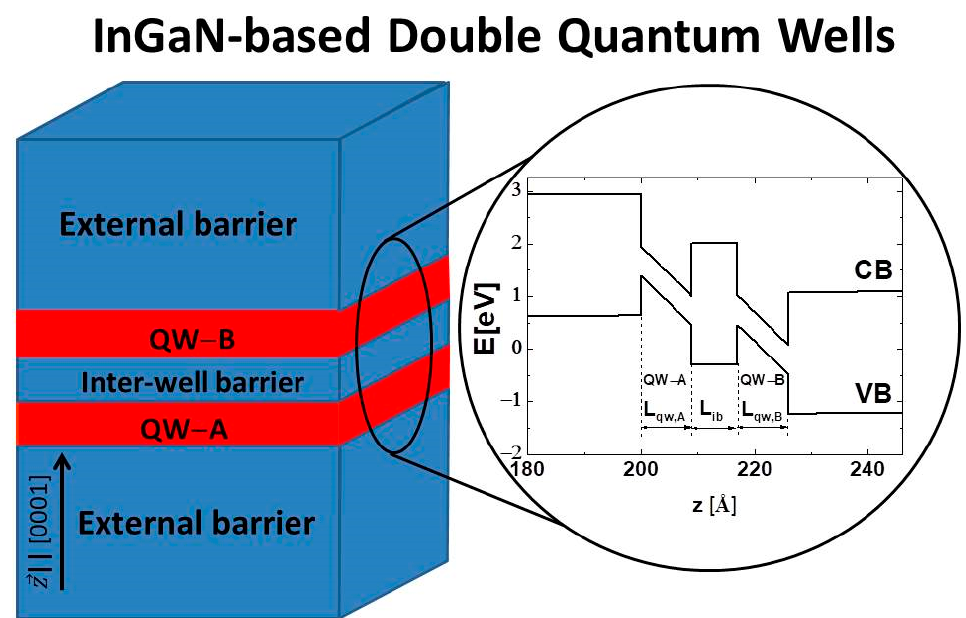
Figure 1. Schematic representation of an InGaN-based DQW heterostructure. On the right side, the CB and VB edge profiles of an exemplary structure containing InN/In 0.3292 Ga 0.6708 N DQWs with L qw , A = 3 MLs , L qw , B = 3 MLs , and L ib = 3 MLs